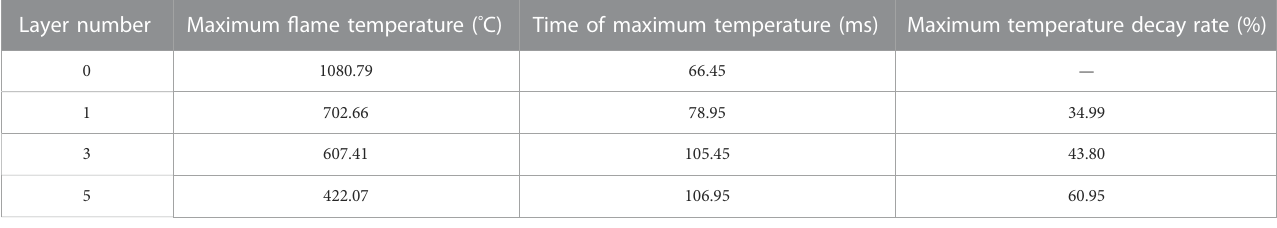
TABLE 3 Characteristic values of fl ame temperature.